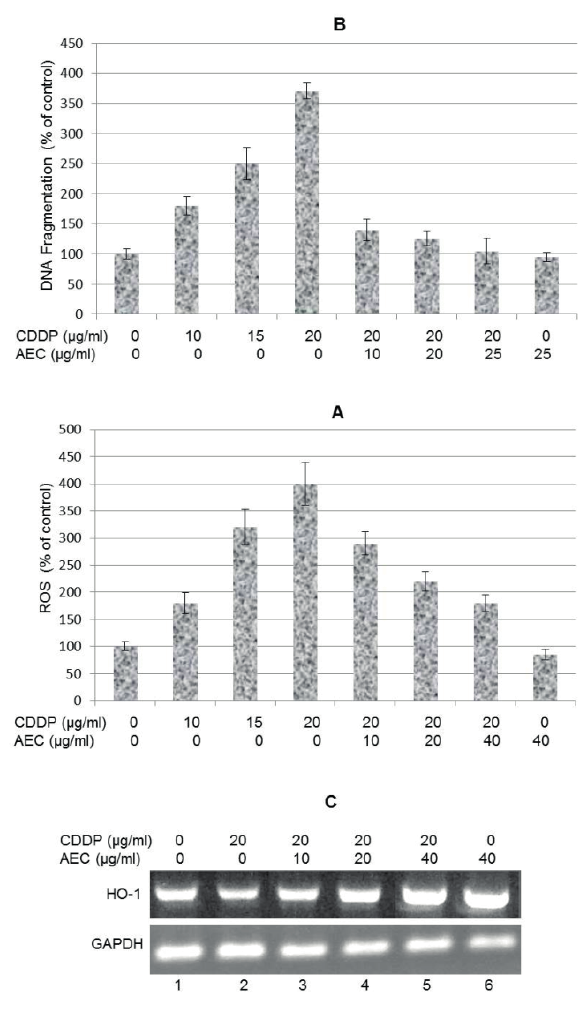
Fig. 4. aec prevented cddp-induced ros generation and dNa fragmentation, and mediated up-regulation of Ho-1 ex- pression. (a) The results show that cddp remarkably induced ros production, in a dose-dependent manner, aec abrogated potentiality of cddp-induced ros generation. (B) percentage of dNa fragmentation as determined by the diphenylamine assay. The experiments were repeated three times in triplicates, and values are reported as the mean ± sd. (c) Vero cells were treated with cddp and/or aec for 24 h. The results show that cddp reduced level of Ho-1 compared to the control, aec promoted level of Ho-1 mrNa, in dose-dependent manner. The experiments were repeated three times in triplicates, and values are reported as the mean ±